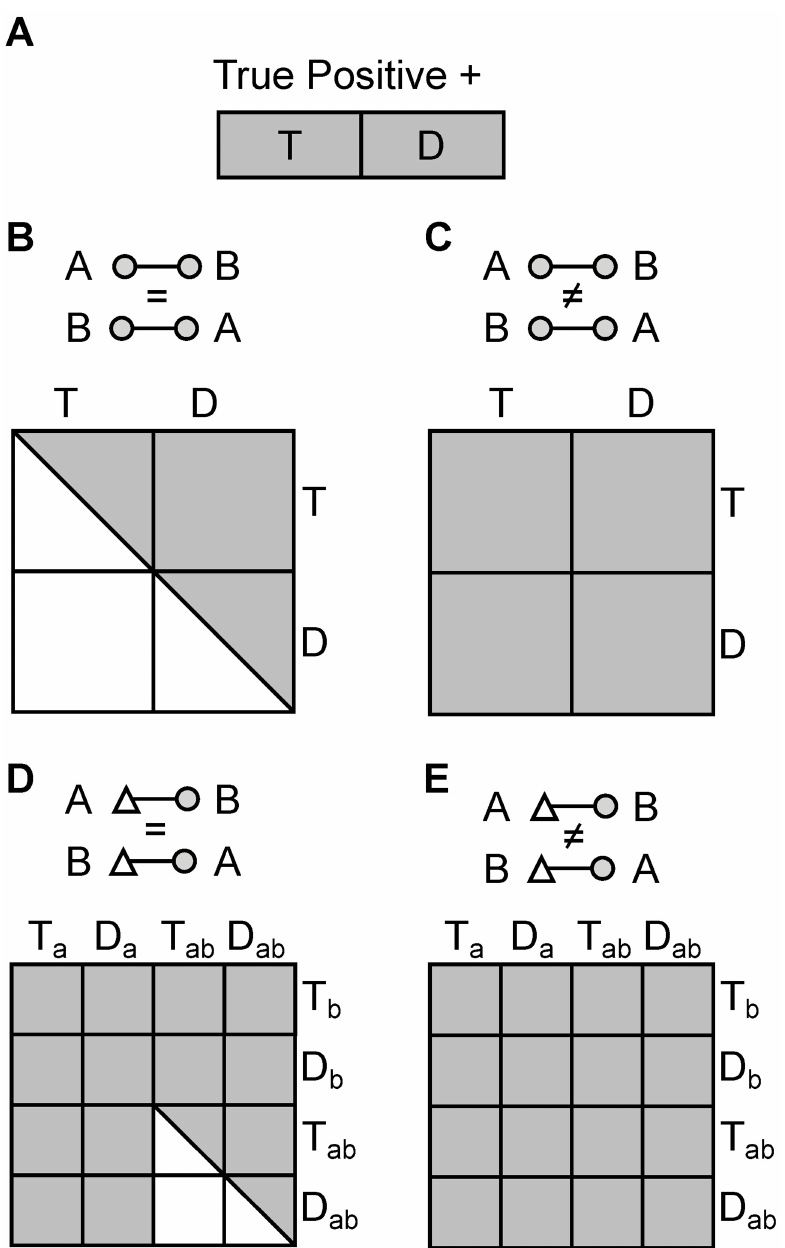
Fig 1. Random search spaces for false positive matches. To model matches where one correct and one incorrect partner are combined requires considering a linear random match space (A). In contrast, when modelling matches with two incorrect partners it requires construction of a quadratic random match space depending on whether the cross-linker is homodimeric, non-directional (B), homodimeric, directional (C), heterodimeric, non-directional (D), or heterodimeric, directional